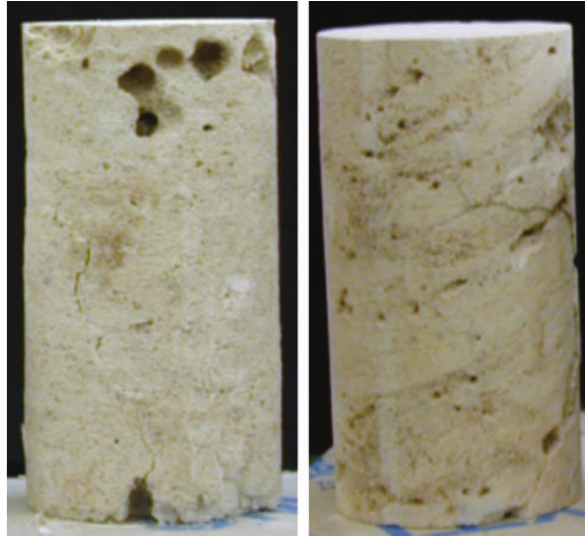
Figure 8 Compression specimens made from Kenchreae